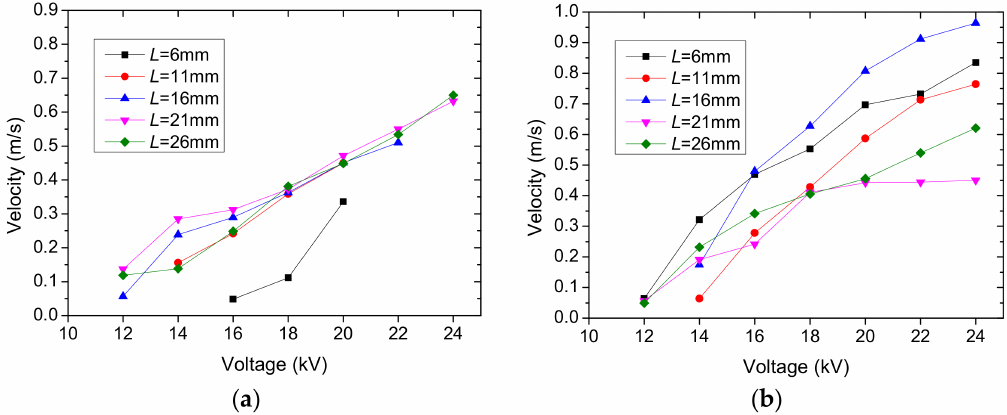
Figure 12. Variation of ionic wind velocity with the applied voltage with different needle-ring distances for five needles: ( a ) positive corona discharge; and ( b ) negative